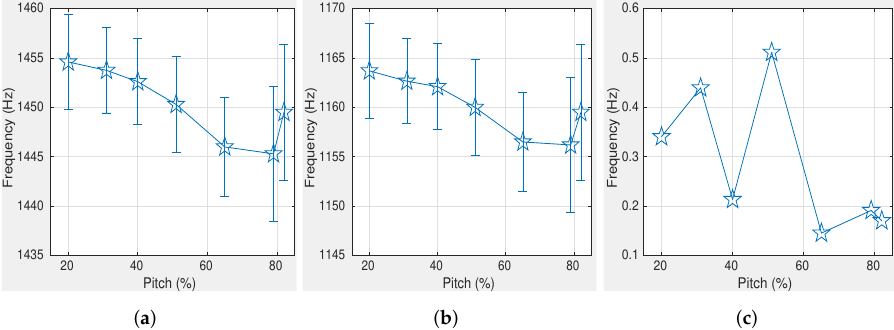
Figure 8. The mean and standard deviation of frequency variations in ship-radiated underwater FM tonal signals, ( a ) within 1435–1460 Hz and ( b ) within 1145–1170 Hz, at different propeller pitch ratios. ( c ) The modulation frequency of FM tonal signals at different propeller pitch ratios.